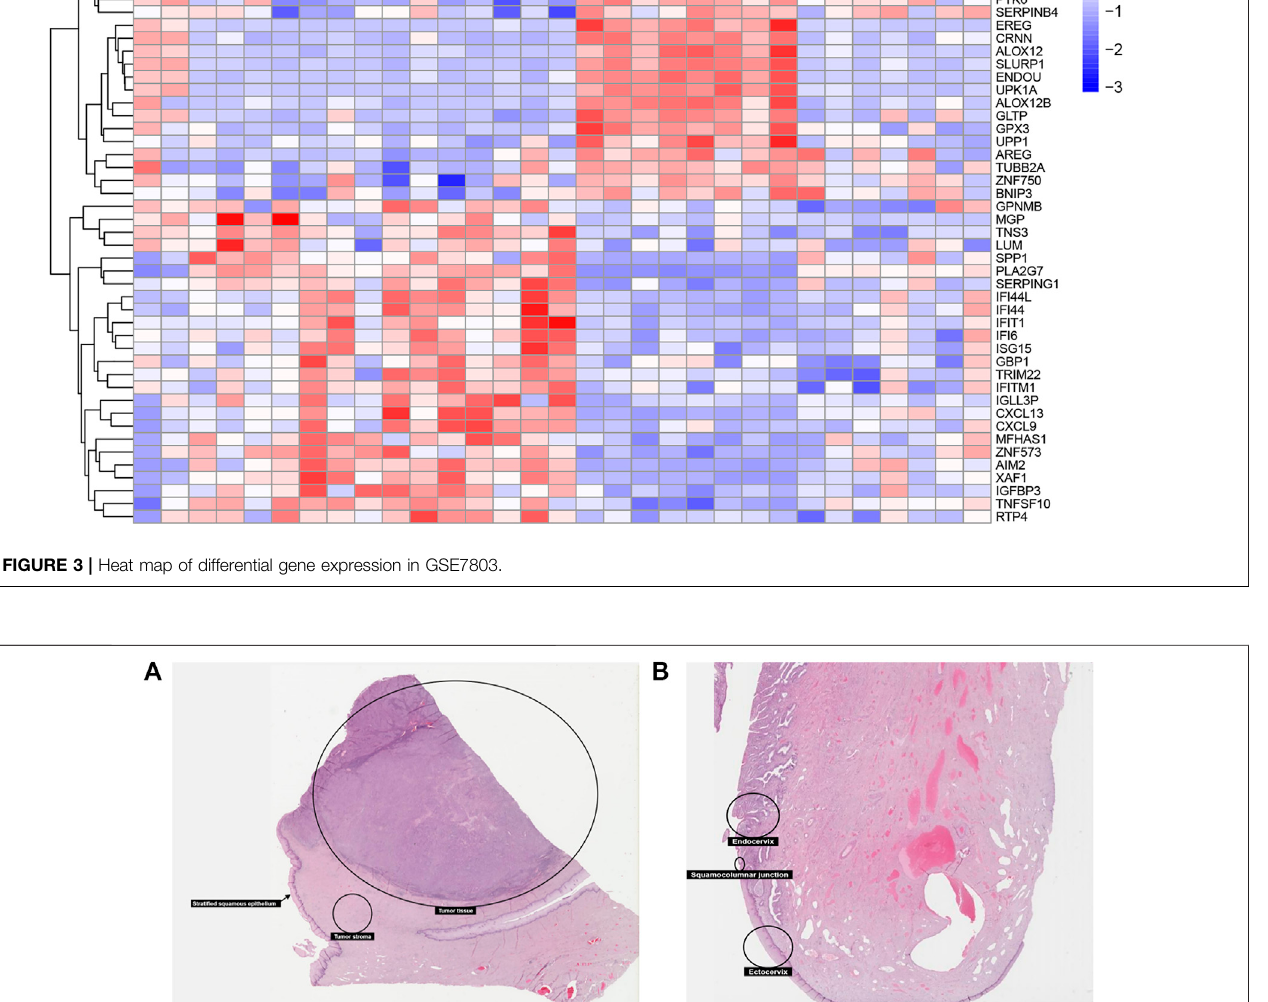
Frontiers in Genetics |